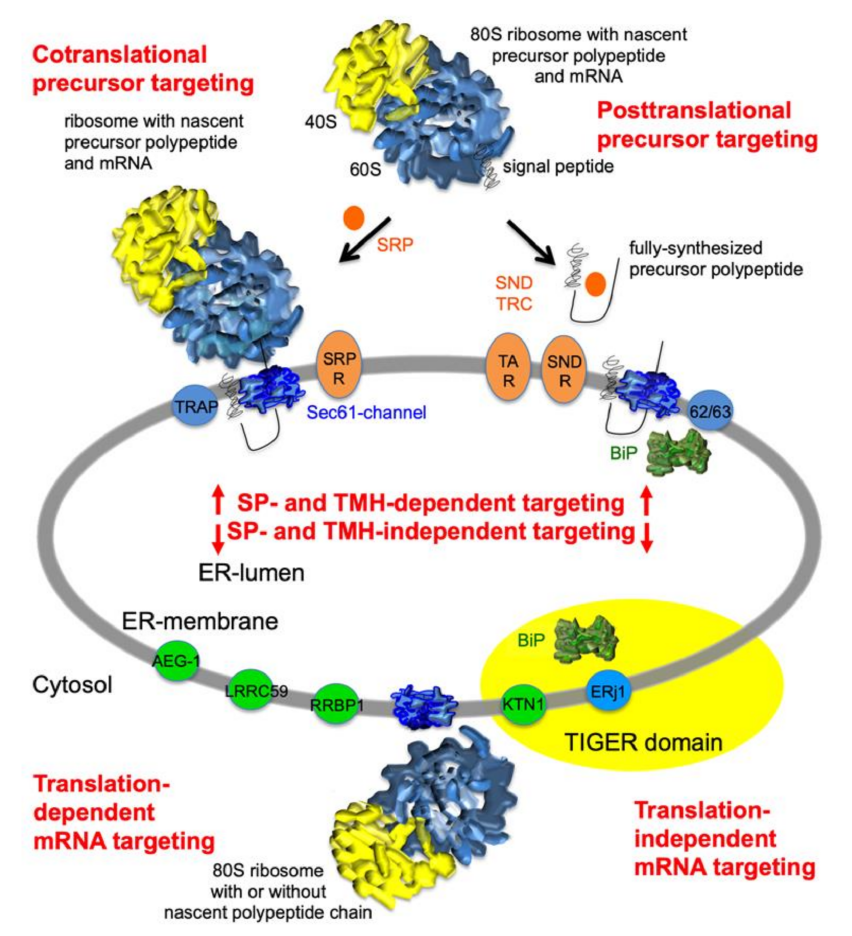
Figure 1. Mechanisms of protein and mRNA targeting to the human endoplasmic reticulum (ER). Import of most precursor polypeptides into the ER involves the heterotrimeric Sec61 channel in the ER membrane, which can facilitate membrane insertion of membrane proteins with N-terminal transmembrane helices (TMHs) and translocation of soluble proteins with N-terminal signal peptides (SPs). Most SPs and TMHs of nascent precursor polypeptides are targeted to the ER membrane by SRP and its heterodimeric receptor in the ER membrane (SRPR), others are targeted post-translationally by the TRC or SND pathway. In addition, there are mechanisms for mRNA targeting to the ER, which either target mRNA to ER-bound ribosomes or mRNA that is present in ribosome-nascent chain (RNC) complexes with chains too short to involve their SPs or TMHs in the targeting reaction. The putative receptors for these mechanisms in the ER membrane are AEG-1, LRRC59, RRBP1, and KTN1 (shown as green circles) and are supposed to also bind unrelated mRNAs. Additional ER membrane proteins support Sec61 channel gating (shown as blue